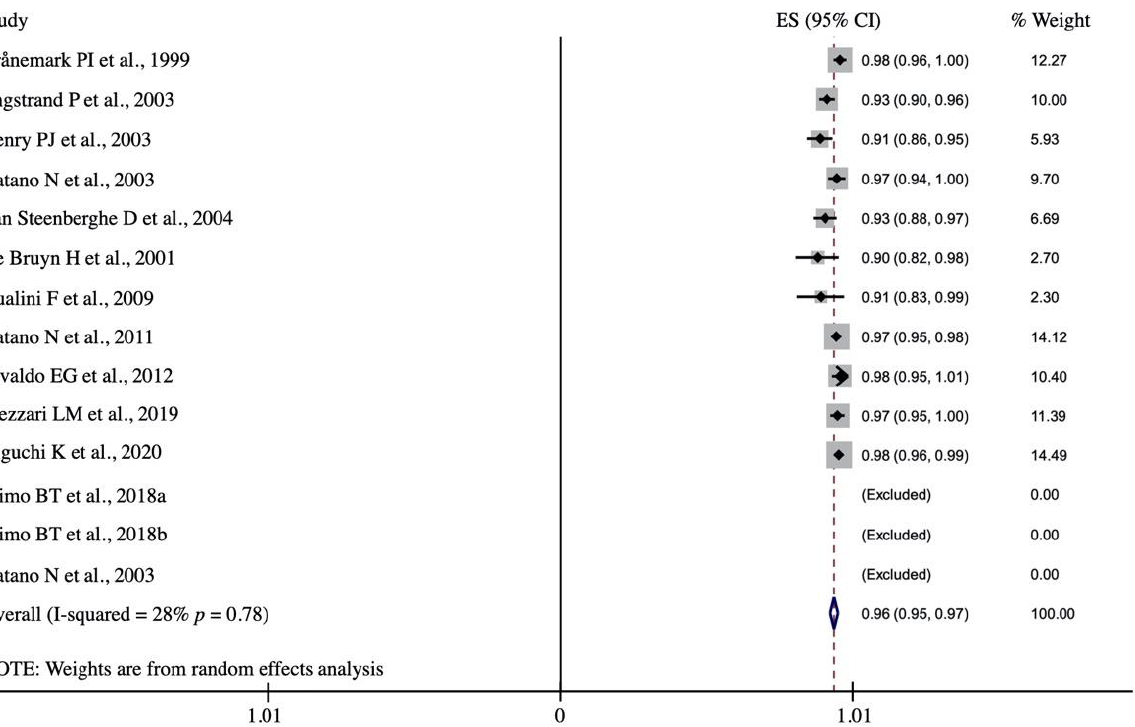
Figure 2. Forest plot. Implant survival rate after 1–6-year follow-up. Moderate statistical heterogeneity was detected between the groups, so a random effects model was applied [X 2 = 22.94 (df = 10); p = 0.011; I 2 = 56.4%]. The prosthetic survival rate was reported in 11 studies and was estimated to be 97.0% (95% CI: 95.7–98.3%; p = 0.001). Low heterogeneity was detected among the studies for this variable (X 2 = 13.89 (df = 10); p = 0.178; I 2 = 28.0%] (Figure